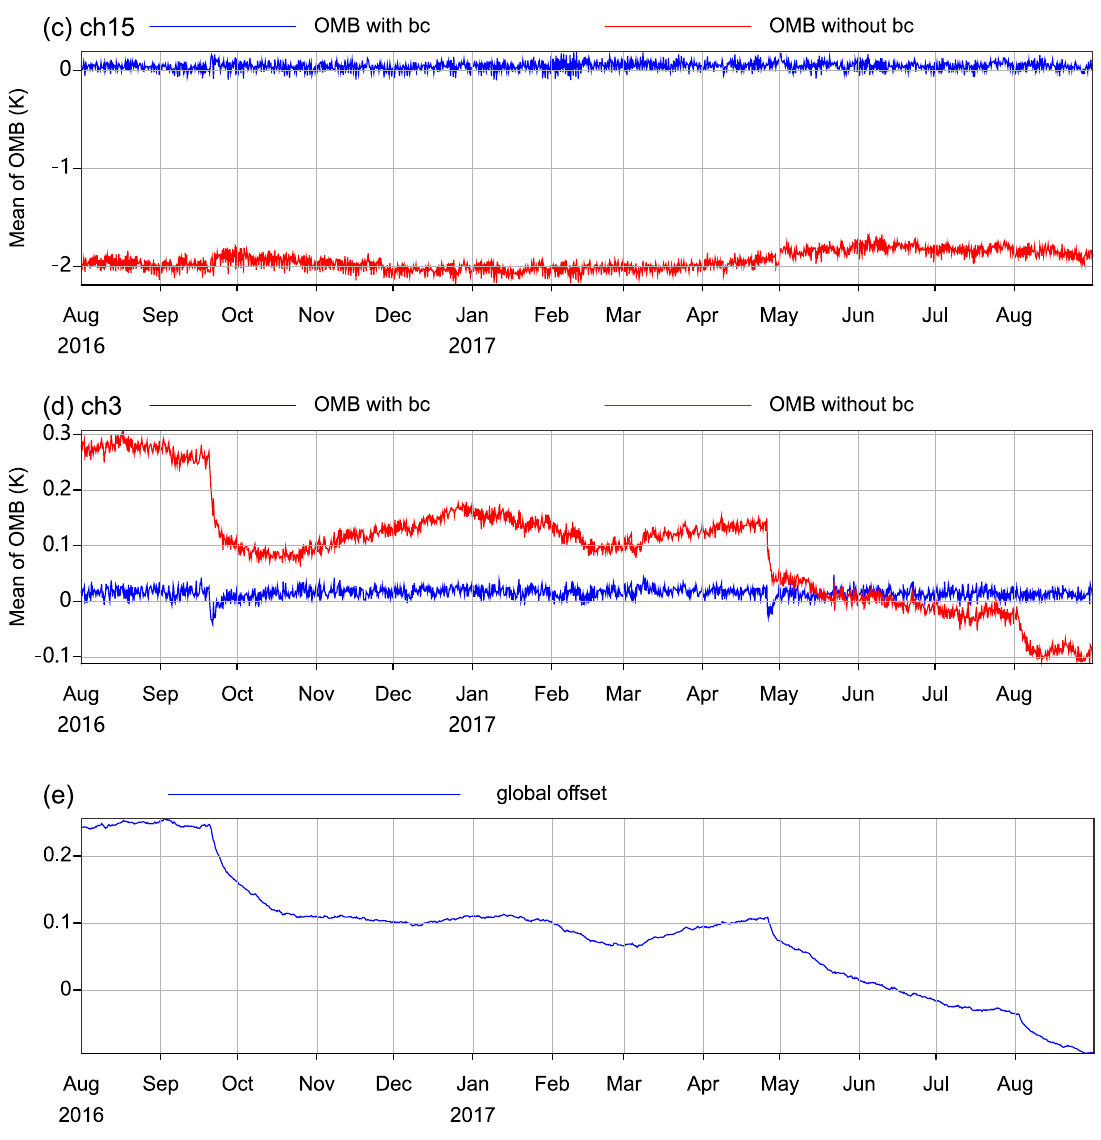
Figure 1. Mean of O − B before (red line) and after (blue line) variational bias correction (VarBC), and the O − B for MWHS-2 channel 11 ( a ), channel 13 ( b ), channel 15 ( c ), and channel 3 ( d ). ( e ) is the global offset coefficient for channel 3 used in the VarBC scheme.